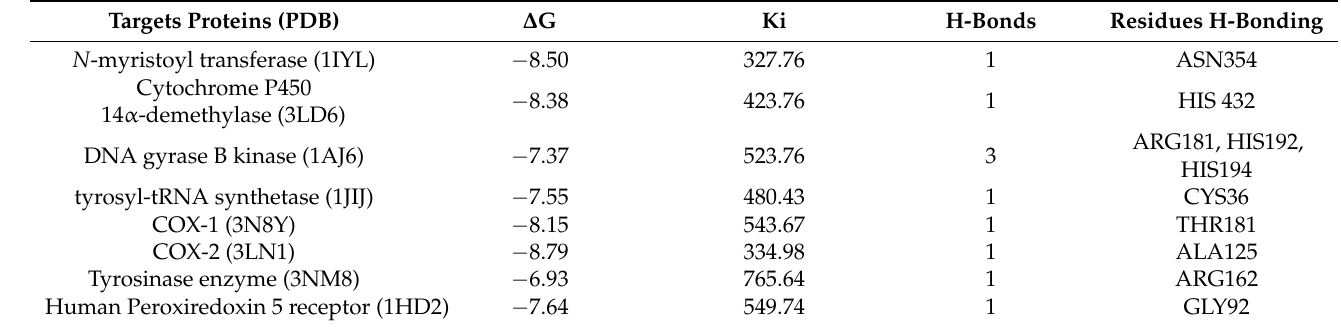
Table 5. The binding energy ( ∆ G: kcal/mol) and inhibition constant (Ki: µ M) for Myristicin with target